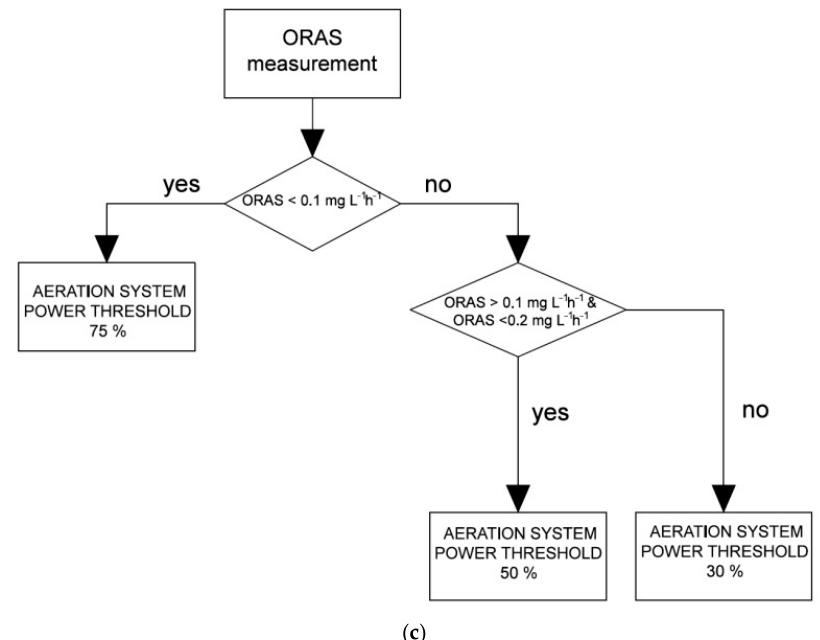
Figure 2. Description of the supervisory control. ( a ) DO threshold. ( b ) ORP threshold. ( c ) Power levels of the aeration systems.